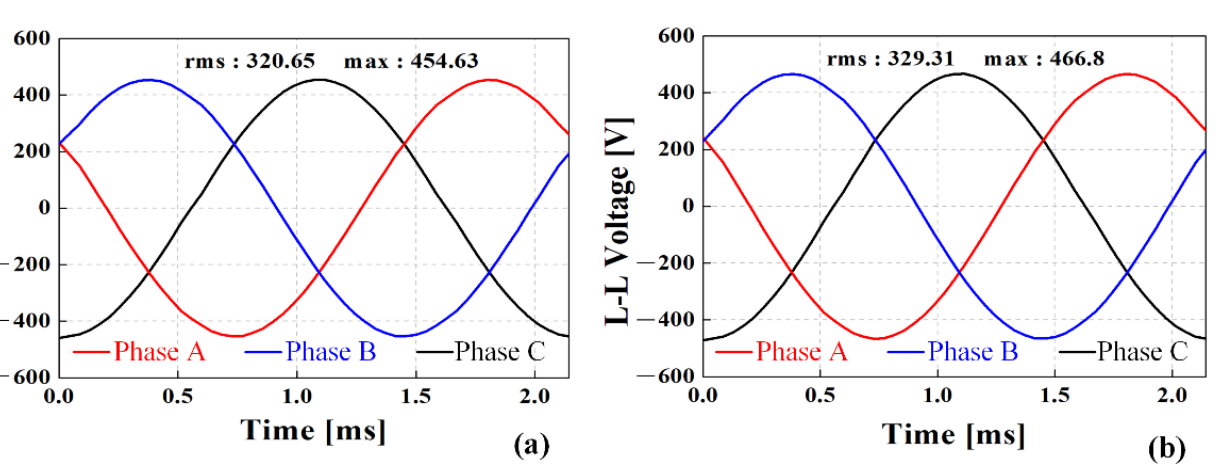
Table 2. Inductance characteristics according to the shaft materials.